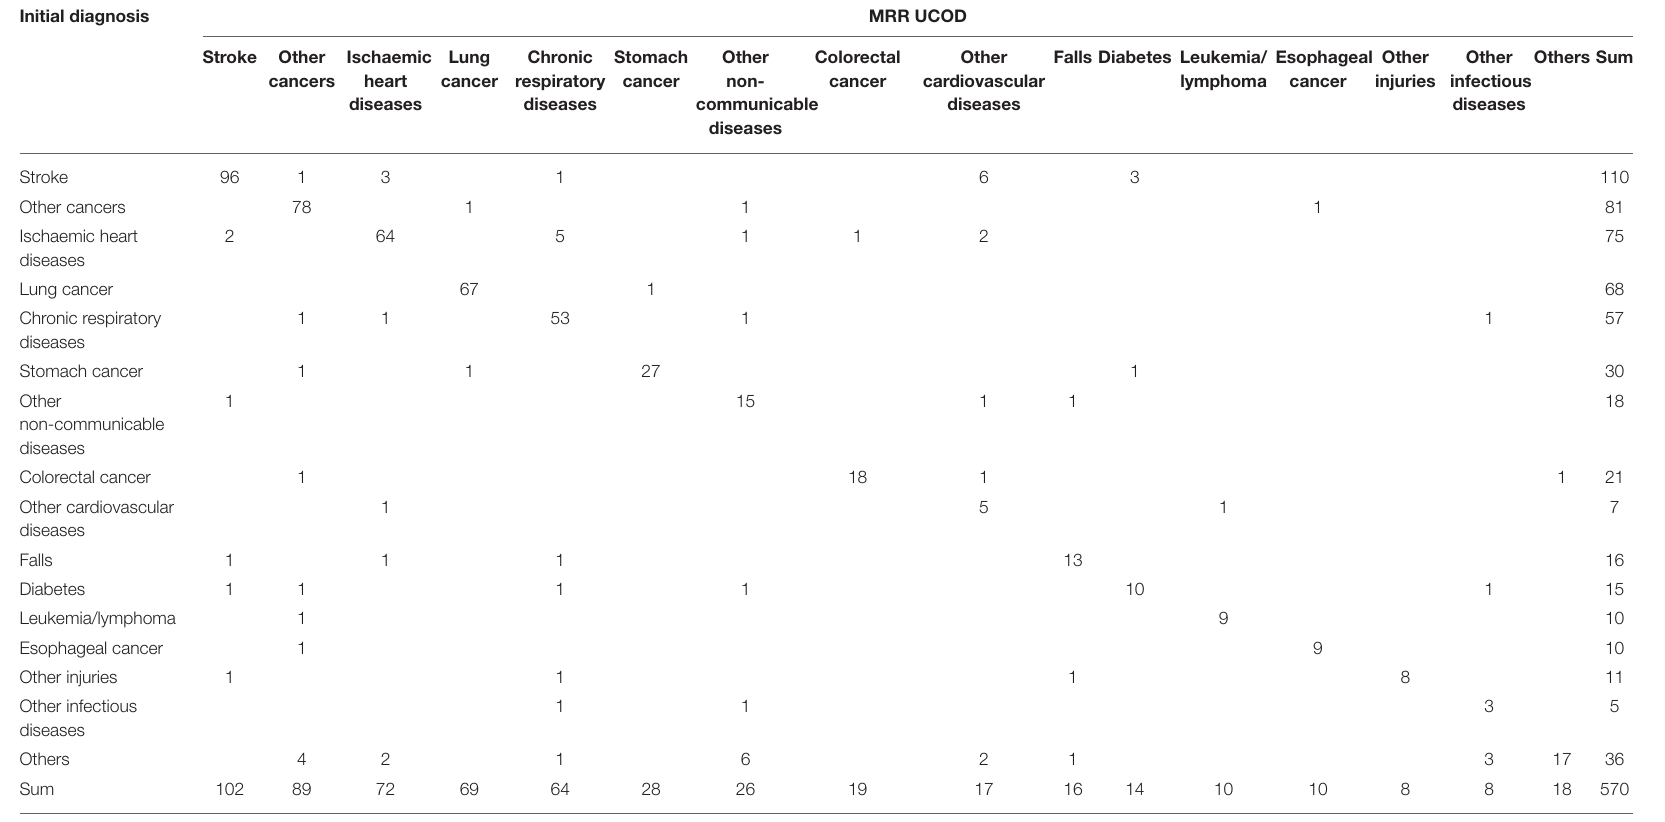
TABLE 4 | The concordance between initial diagnosis before VA and MRR results. Initial